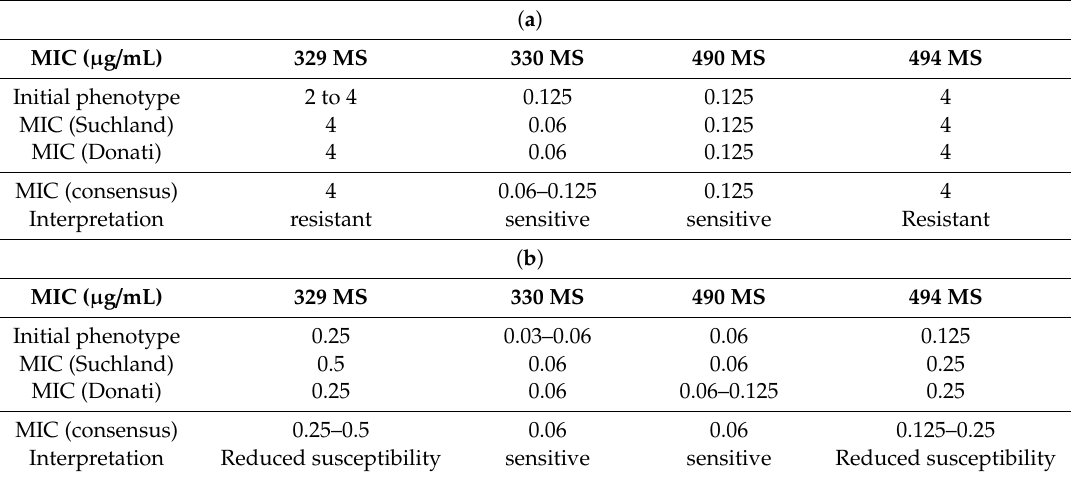
Table 2. ( a ) Susceptibility testing of tetracycline in vitro according to Marti et al. [19], and ( b ) susceptibility testing of doxycycline in vitro according to Marti et al. [19]. MIC: Minimum inhibitory